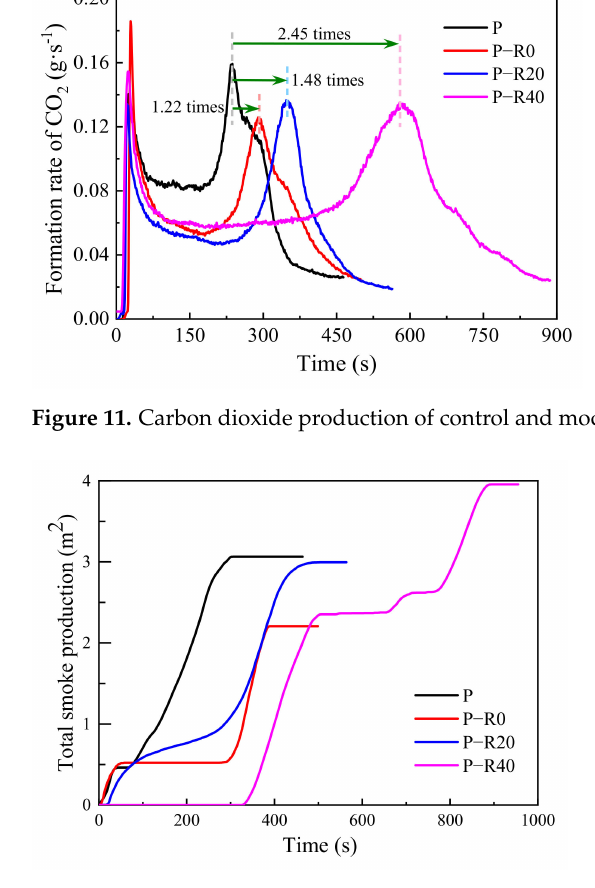
Figure 12. TSP of control and modified wood